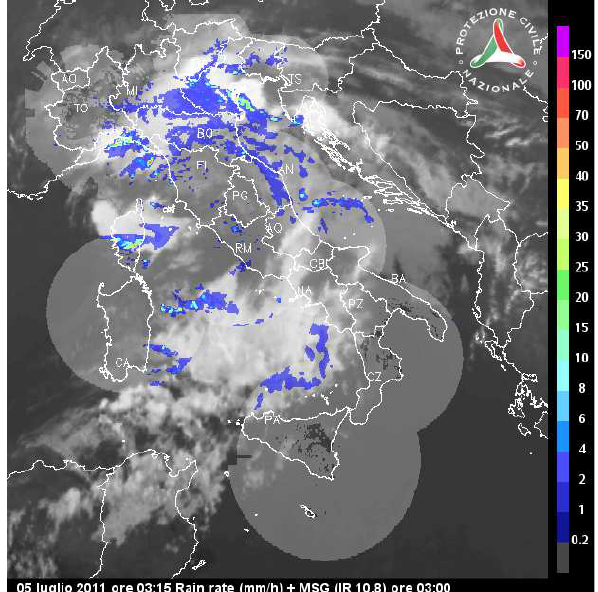
Figure 2: An example of the graphical output of RNC (courtesy of DPC). The surface rain intensity (sri) product is color-coded according to the vertical bar (in mm/h) and layered over the Meteosat Second Generation (MSG) 10.8 m m image (in normalized inverted grey scale). Data obtained from RNC at 01:15 UTC and MSG observations at 01:00 UTC on 5 July 2011 (i.e. within 7 minutes from data in Figure 1). Note that here the time displayed at the bottom is in CEST (Central Europe Summer Time).